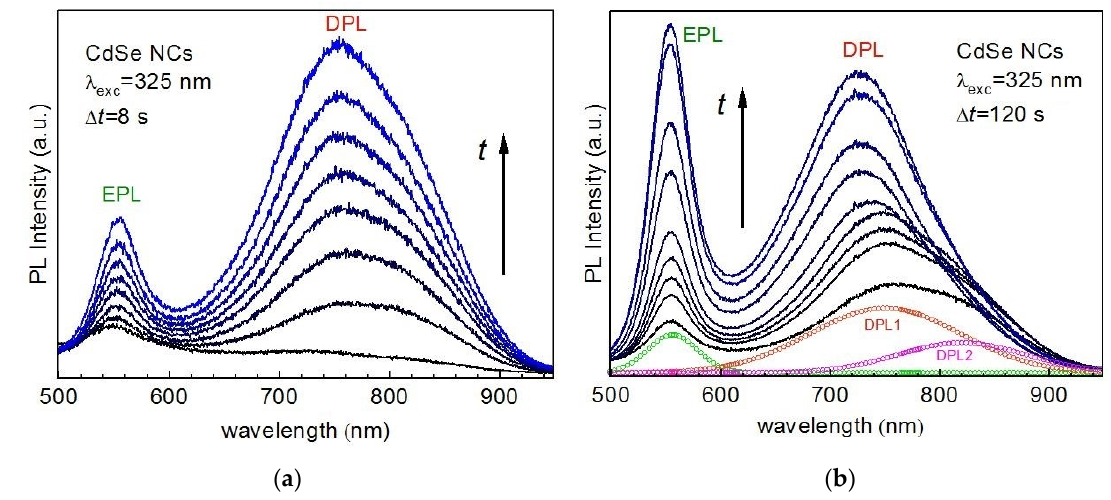
Figure 2. Evolution (from black to blue) of the room-temperature PL spectra ( λ exc = 325 nm, 0.1 W/cm 2 ) of CdSe NCs in a gelatin matrix at different time-scales, with the periods between the spectra equal to 8 s ( a ) and 120 s ( b ). EPL and DPL denotes, respectively, the excitonic emission band and the trap/defect-related band. A representative deconvolution of the latter into two components, DPL1 and DPL2, is shown for the bottom spectrum in ( b ).